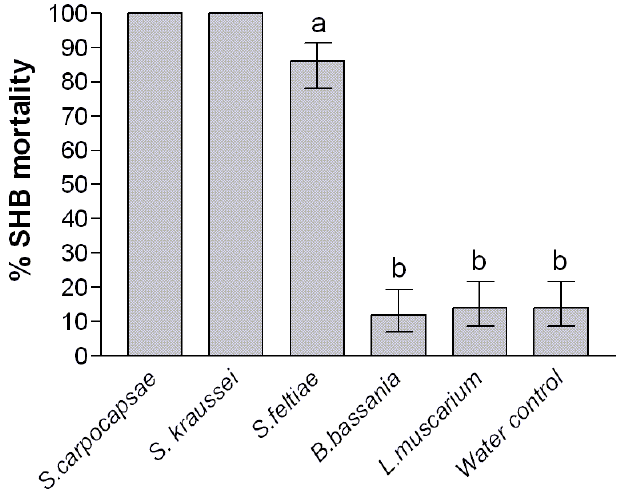
Figure 3. Impact of in-direct exposure of control agents on Aethina tumida wandering larvae. Error bars represent the 95% confidence intervals. Means were separated using least significant differences after adjusting for multiple comparisons. Significantly different means (5% significant level) are represented by suffixes a and b.